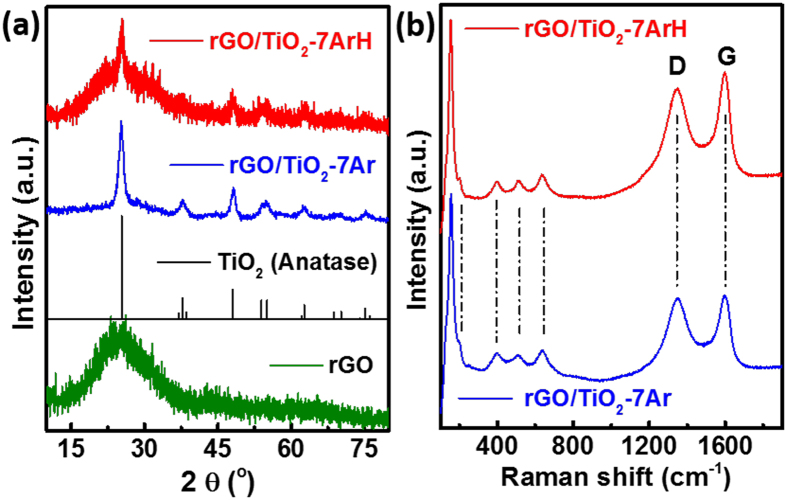
(a) XRD patterns of rGO, the standard TiO2 sample (JCPDS: 99-0008), rGO/TiO2-7Ar and rGO/TiO2-7ArH; (b) Raman spectra of rGO/TiO2-7Ar and rGO/TiO2-7ArH.